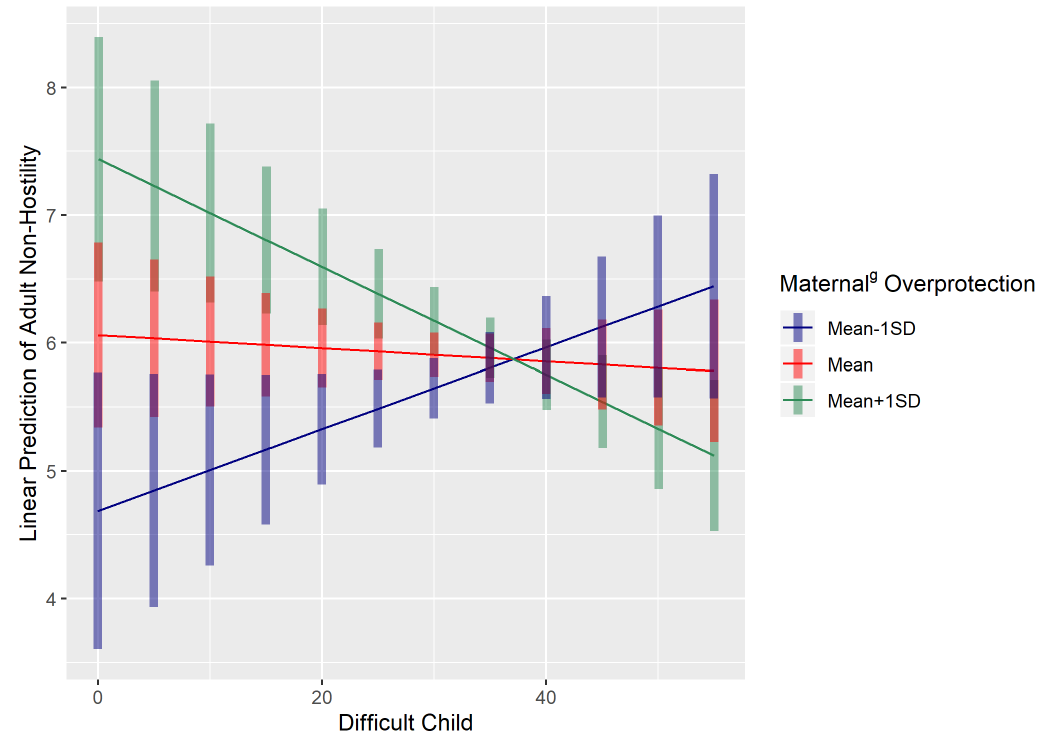
Figure 2. Difficult child scores predict adult non-hostility, moderated by maternal g overprotection levels. At lower values of difficult child score, higher maternal g overprotection predicted greater adult